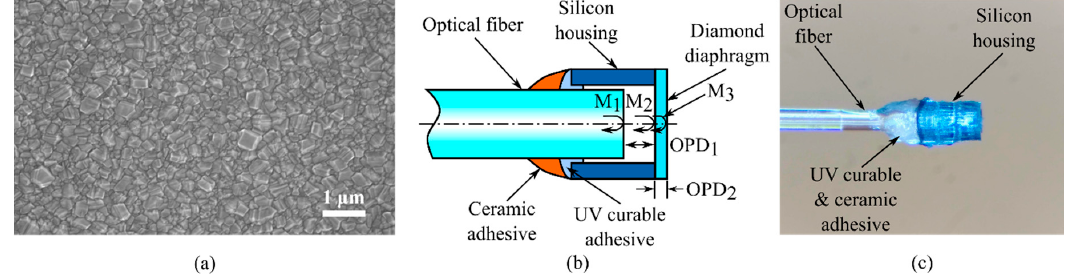
Figure 1. ( a ) A scanning electron micrograph of chemical vapor deposition (CVD) diamond film and ( b ) schematic of the diamond-based pressure sensor with a polymer-ceramic hybrid adhesive; ( c ) microscopic image of a fabricated sensor.